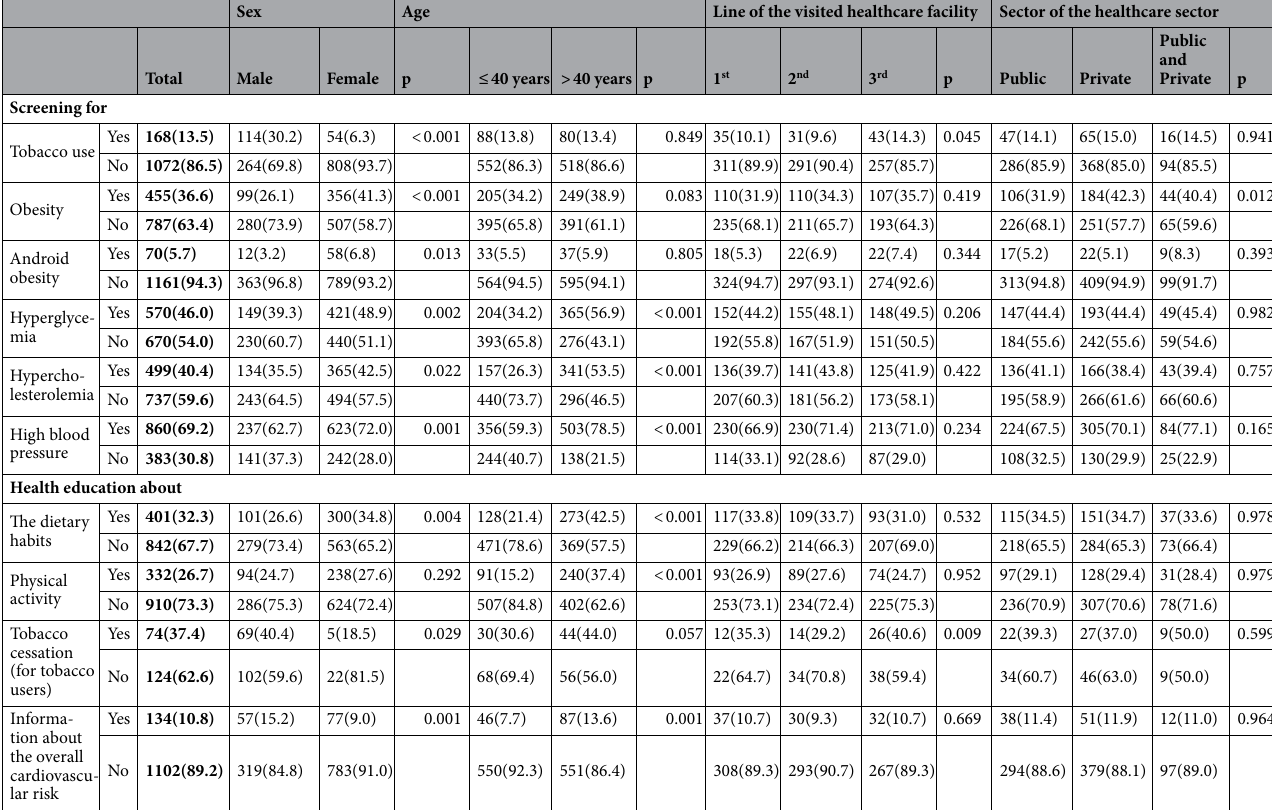
Table 3. Screening and health education practices related to cardiovascular risk factors among te participants that have visited a healthcare facility during the previous year, according to their sociodemographic